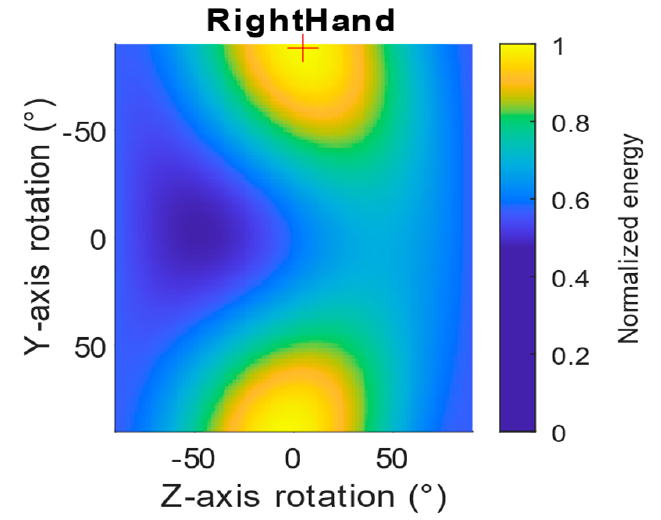
Figure 8. Orientation influence on harvester normalized energy simulation for the right hand from IMU local reference frame. Optimal orientation is indicated by a red cross. Xsens location labels are used.